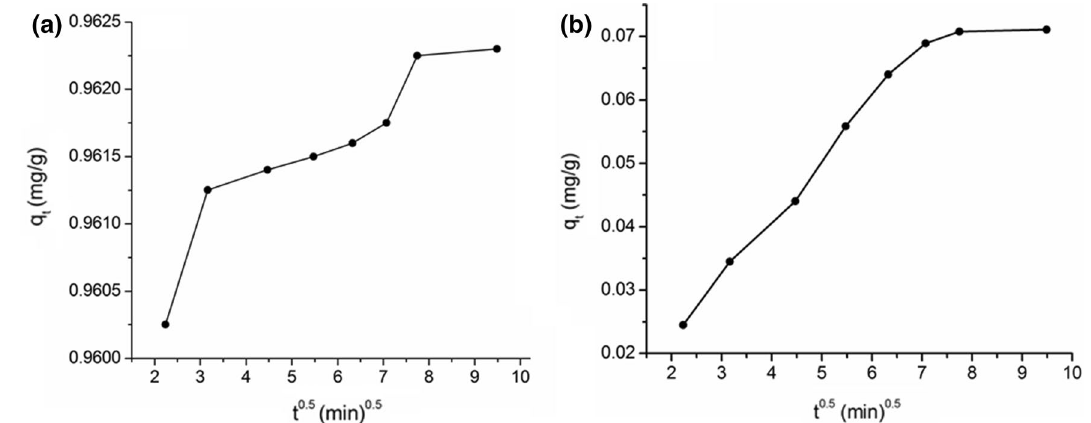
Fig. 5 Intraparticle diffusion plot of simultaneous removal of a phosphate and b nitrate ions